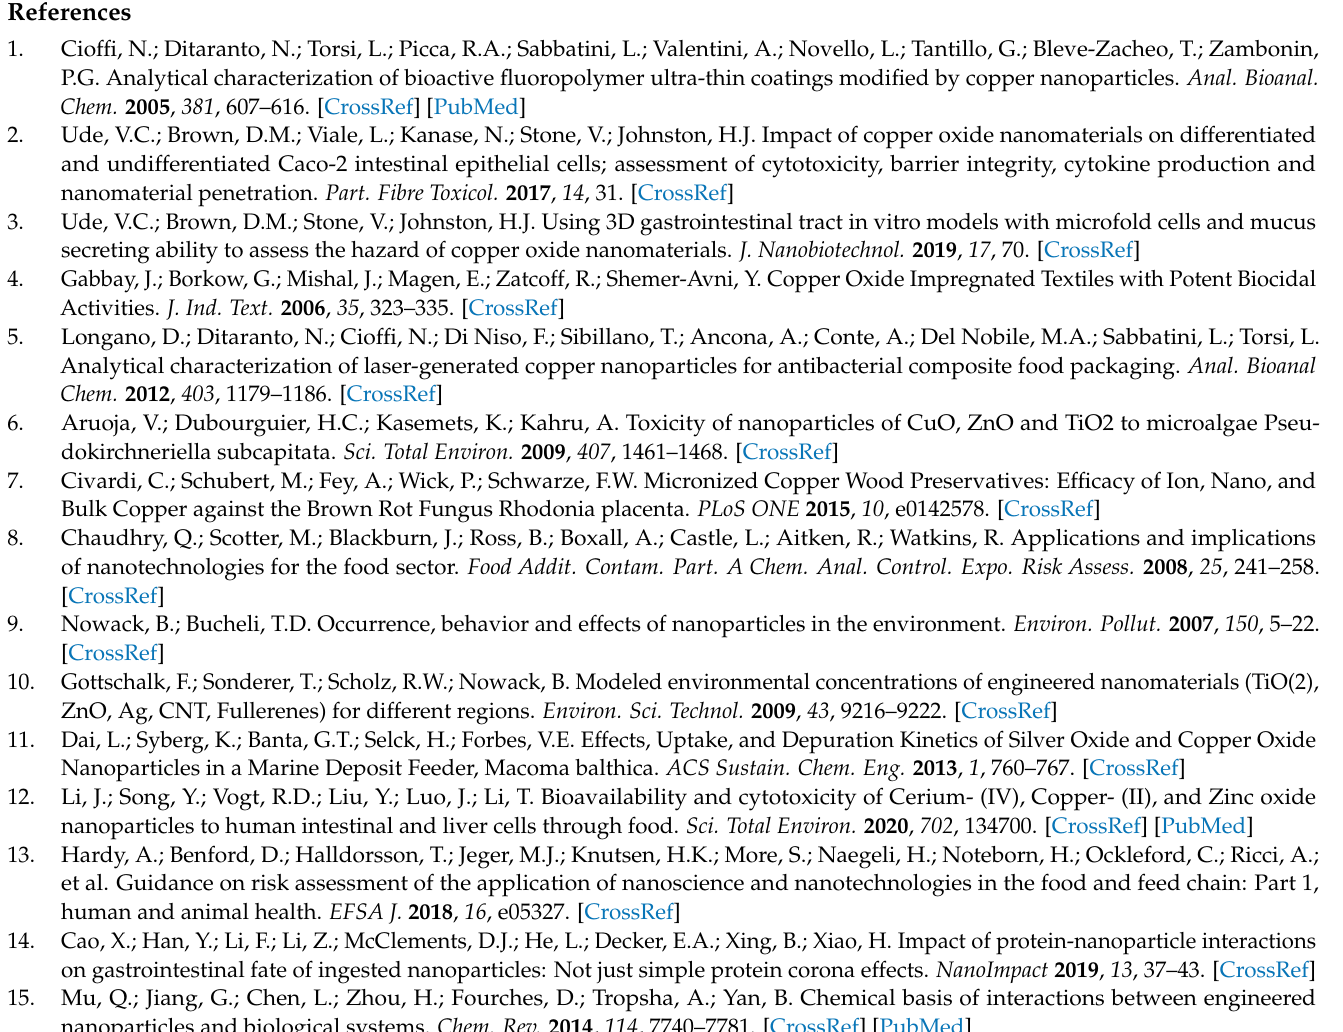
ton staining with phalloidin. Supplementary Figure S7. Cell nuclei staining. Supplementary Figure S8. Mucus staining of mono- and